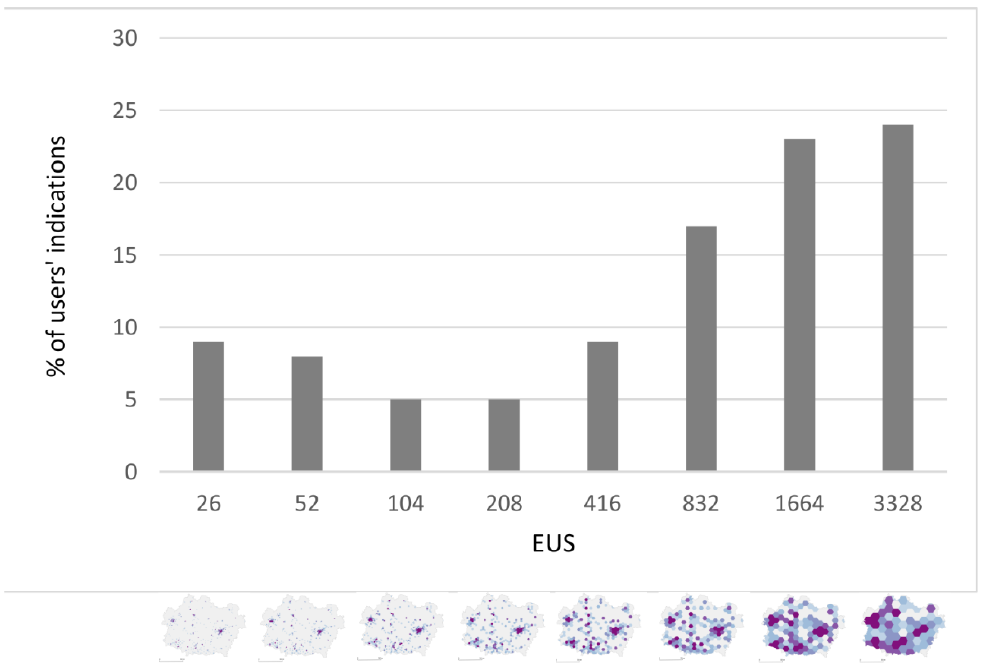
Figure 5. Enumeration unit sizes that, according to the users, do not show the main characteristics of the phenomenon presented on the symbol map.